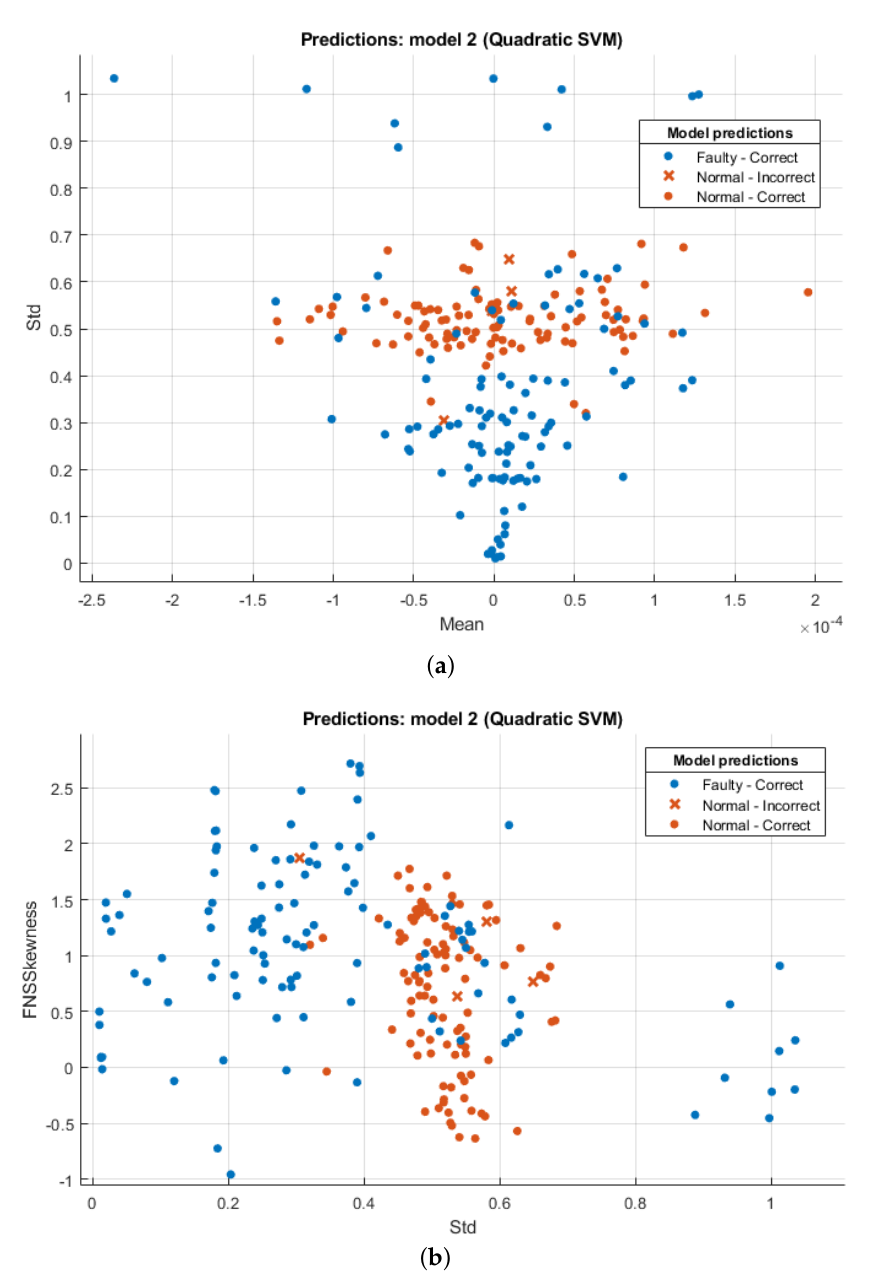
Figure 5. Model Predictions of SVM-Q Classifiers for various combinations of temporal and frequency domain features. ( a ) Temporal Mean and Standard Deviation. ( b ) Frequency standard deviation and